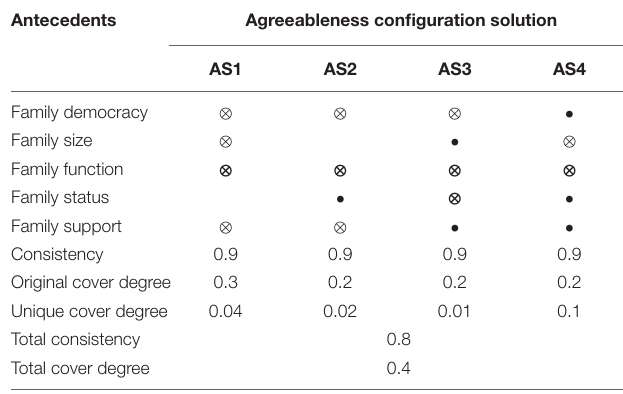
TABLE 7 | Matching analysis of work experience and high original innovation personality. Antecedents